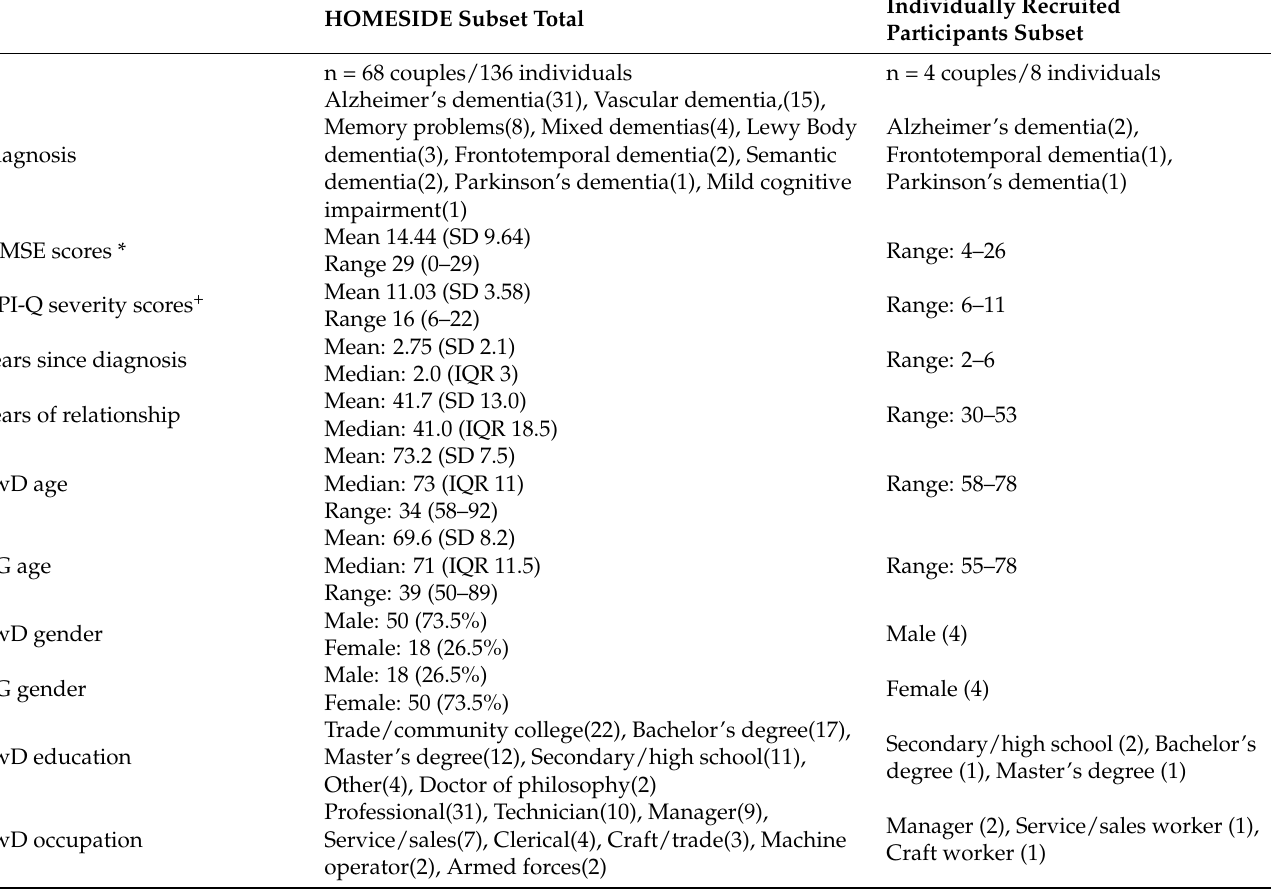
Table 3. Demographic details.